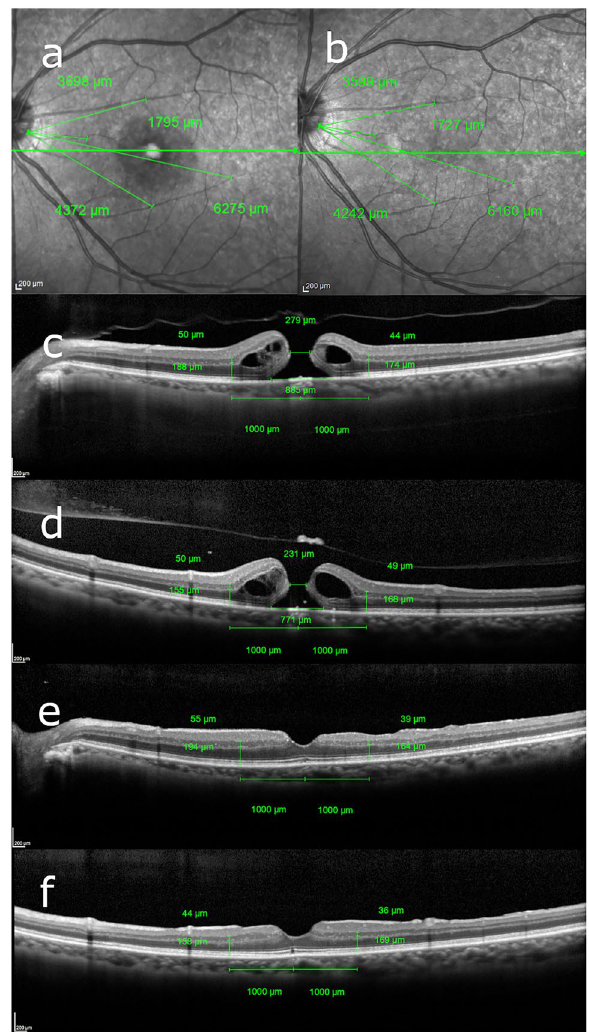
Figure 1. Measurement of optical coherence tomography parameters in macular hole using Spectralis. ( a ) Near-infrared images of Spectralis optical coherence tomography were used to measure the retinal distance between the temporal margin of the optic disc and the intersections or bifurcations of retinal vessels. Four intersections or bifurcations of retinal blood vessels in the temporal, nasal, superior and inferior the Early Treatment Diabetic Retinopathy Study subfields were selected. ( b ) Retinal distances at 6 months postoperatively were measured with the same methods. ( c ) In horizontal scan images, the horizontal minimum and basal diameters of the MH were measured. Inner nuclear layer (INL) and outer retinal layer (OR) thicknesses were measured 1000 μm away from the center of MH temporally and nasally. ( d ) In vertical scan images, the vertical minimum and basal diameters of MH were measured. The INL and OR thicknesses were measured with as was done for horizontal images. The right side of the image is superior retina, and the left is inferior. ( e ) Retinal layer thicknesses in the horizontal scan image at 1 month postoperatively. ( f ) Retinal layer thicknesses in the superior and inferior sectors in the vertical scan image at 6 months